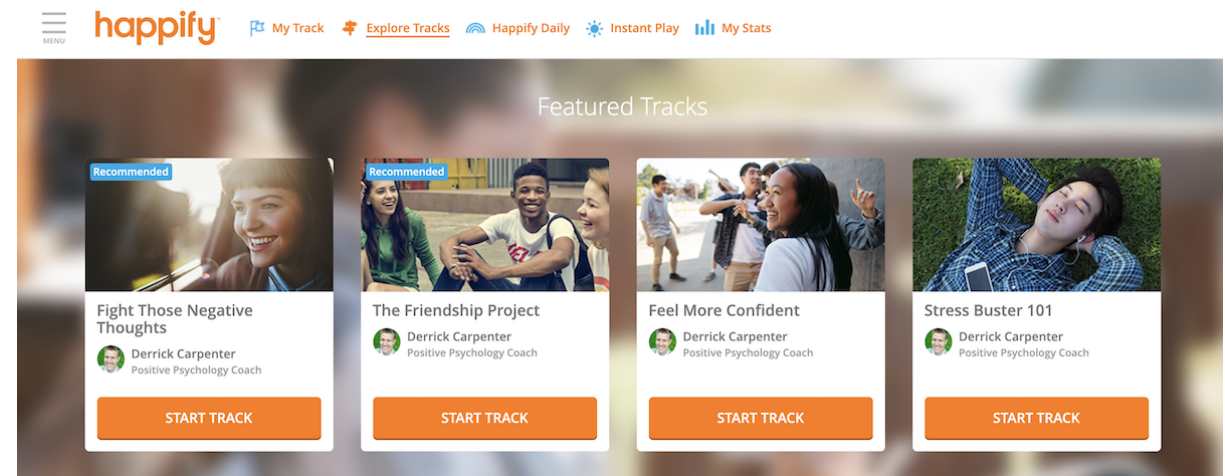
Figure 1. Screenshot of Happify for